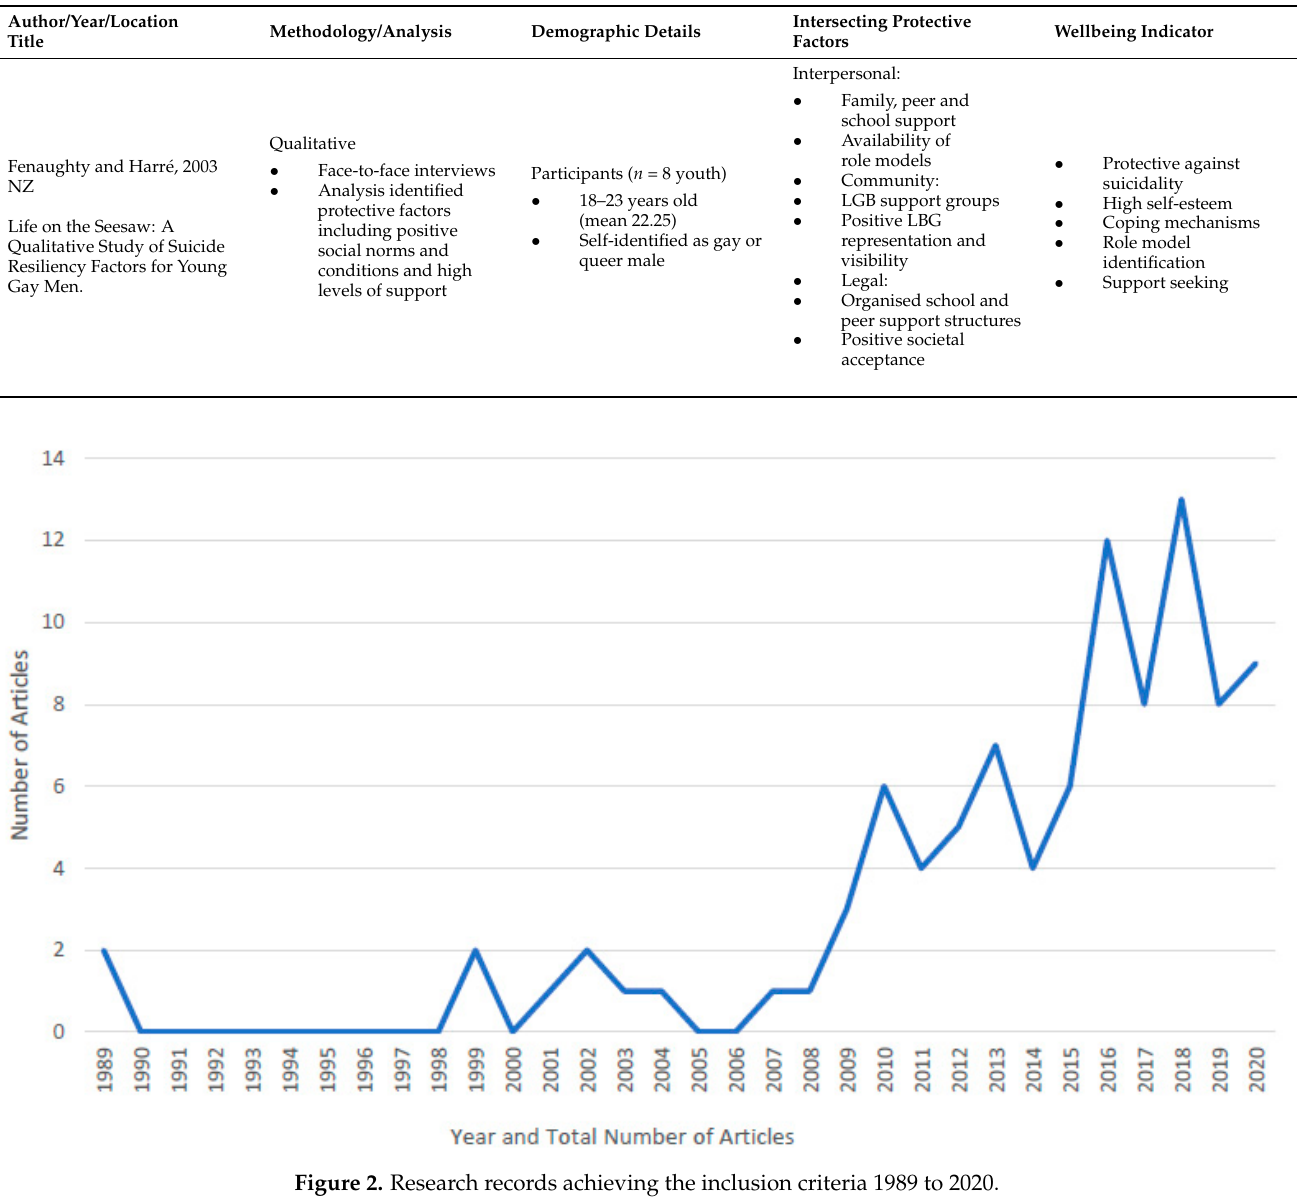
Figure 2. Research records achieving the inclusion criteria 1989 to 2020. Table 2. Quantitative records of interpersonal relations: parental, peer and provider protective factors for LGBTI+ youth wellbeing ( n = 21).